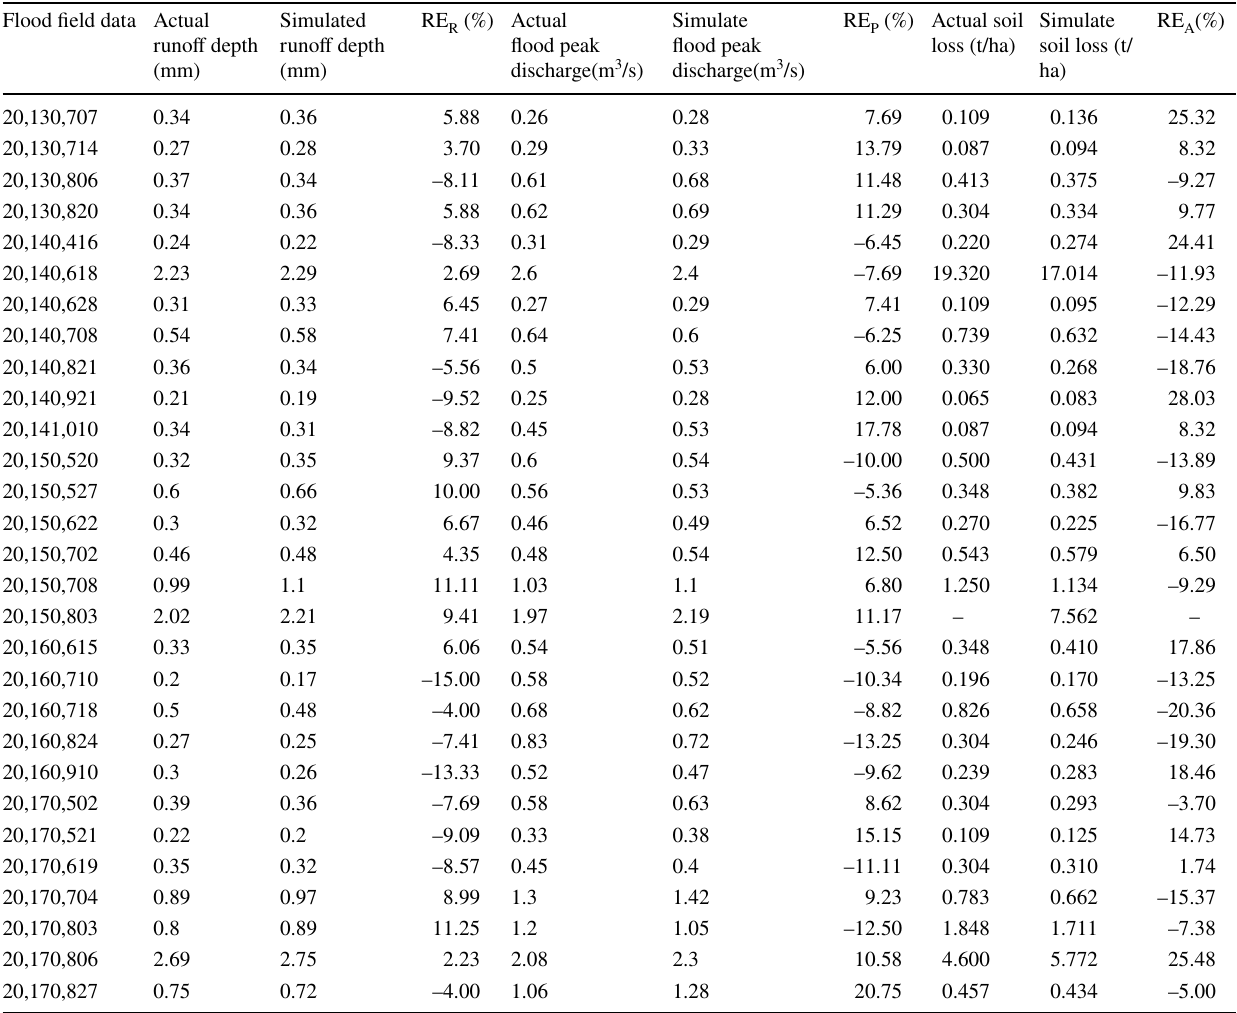
Table 4 Results during the period of model calibration and